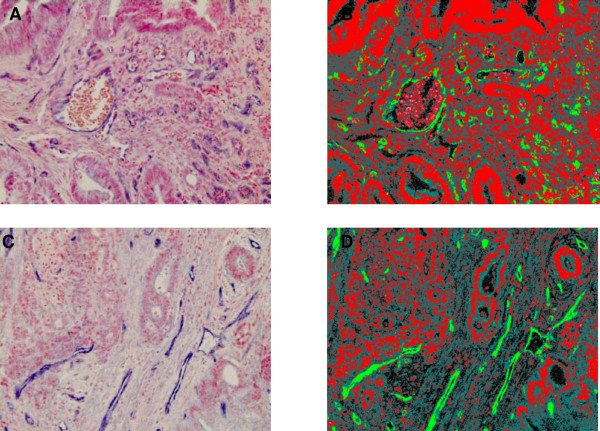
In situ hybridization (ISH) visualising the expression of miRNA-126 in tumour vasculature. A represents an image from a patient with colon cancer in which the mean ISH signal (the blue signal) from all the analysed images resulted in an area of 4280 μm2. B the pixel classifier corresponding to image A. C also represents an image from a patient with colon cancer with a mean ISH signal of 2736 μm2. D the pixel classifier corresponding to image C.